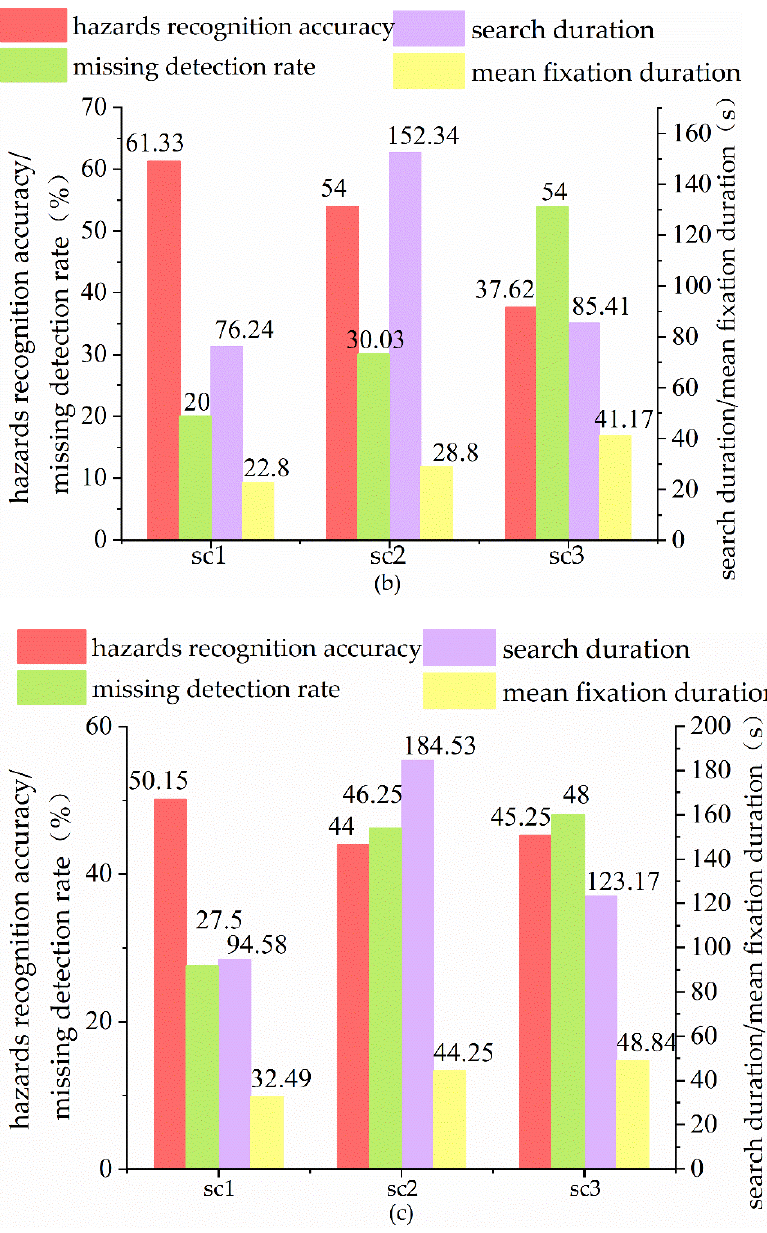
Figure 7. Statistical chart of hazard recognition of three groups. ( a ) Hazard recognition of group A1, ( b ) Hazard recognition of group A2, ( c ) Hazard recognition of group A3.